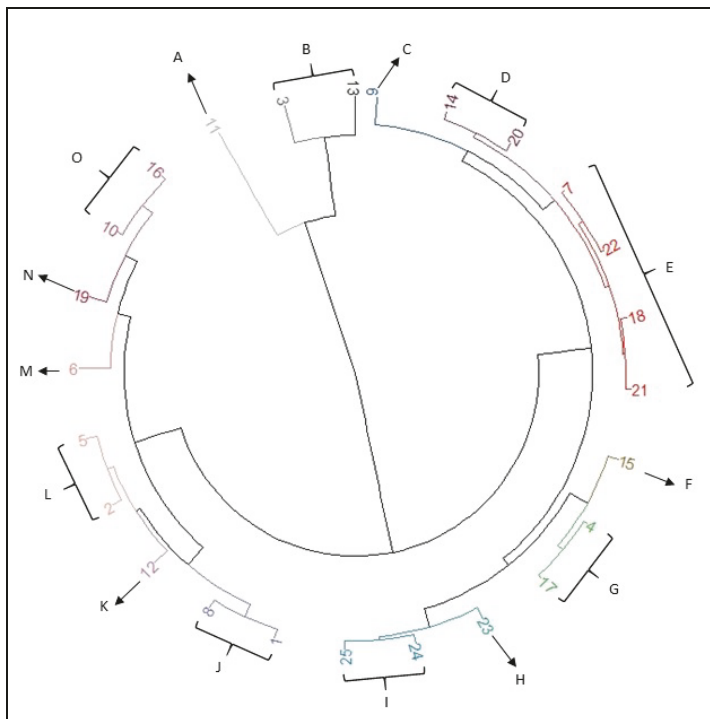
Figure 4: Associations among 25 sesame accessions revealed by circular clustering analysis on the basis of combined morphological and molecular Euclidean distance values. 1=C1, 2=C2, 3=C3, 4=C4, 5=C5, 6=K1, 7=K2, 8=K3, 9=K4, 10=K5, 11=S1, 12=S2, 13=S3, 14=S4, 15=S5. 16=T1, 17=T2, 18=T3, 19=T4, 20=T5, 21=W1, 22=W2, 23=W3, 24=W4,